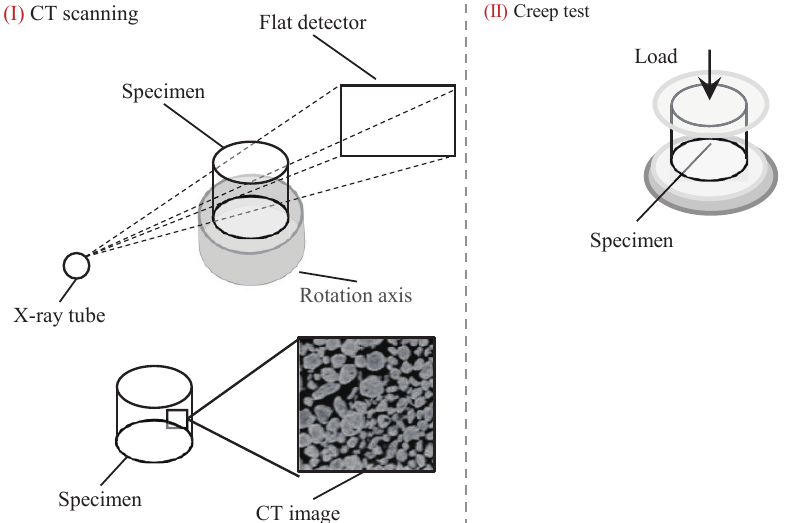
Figure 4. Schematic diagram of damage inspection process.